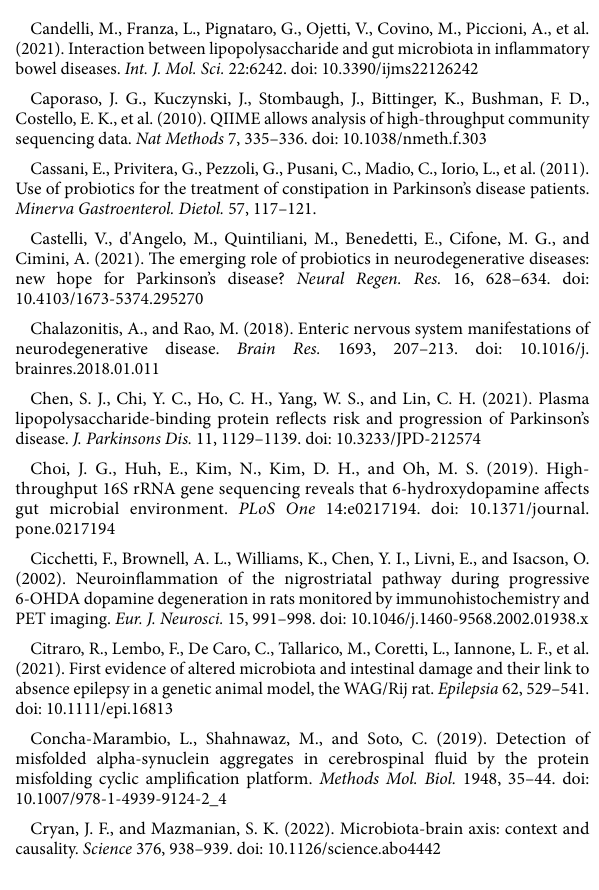
SUPPLEMENTARY FIGURE S1 (A) Western blot analysis of occludin levels in the four experimental groups: Sham + placebo, Sham + Symprove TM , model + placebo and model + Symprove TM ( n =2 per experimental group). (B) Western blot examples of iNOS and NF- κ B levels in the four experimental groups: Sham + placebo, Sham + SymproveTM, model + placebo and model + Symprove TM ( n =2 per experimental group). (C) Western blot examples of COX-2 and I κ -B α levels in the four experimental groups: Sham + placebo, Sham + Symprove TM , model + placebo and model + Symprove TM ( n =2 per experimental